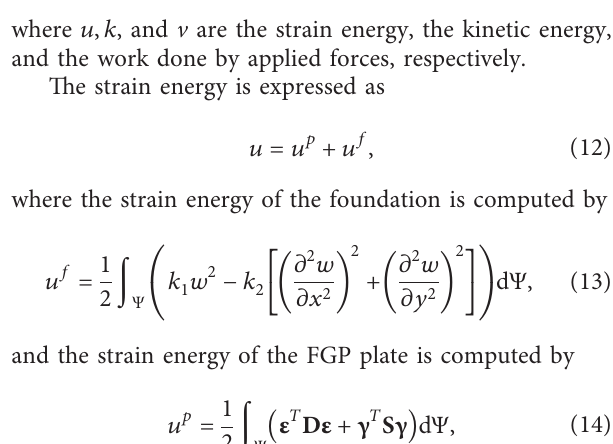
Figure 2: Distribution of porosity and typical material property. (a) Distribution of porosity along the z -axis. (b) Distribution material property with k � 0. (c) Distribution material property with k � 1. (d) Distribution material property with k �